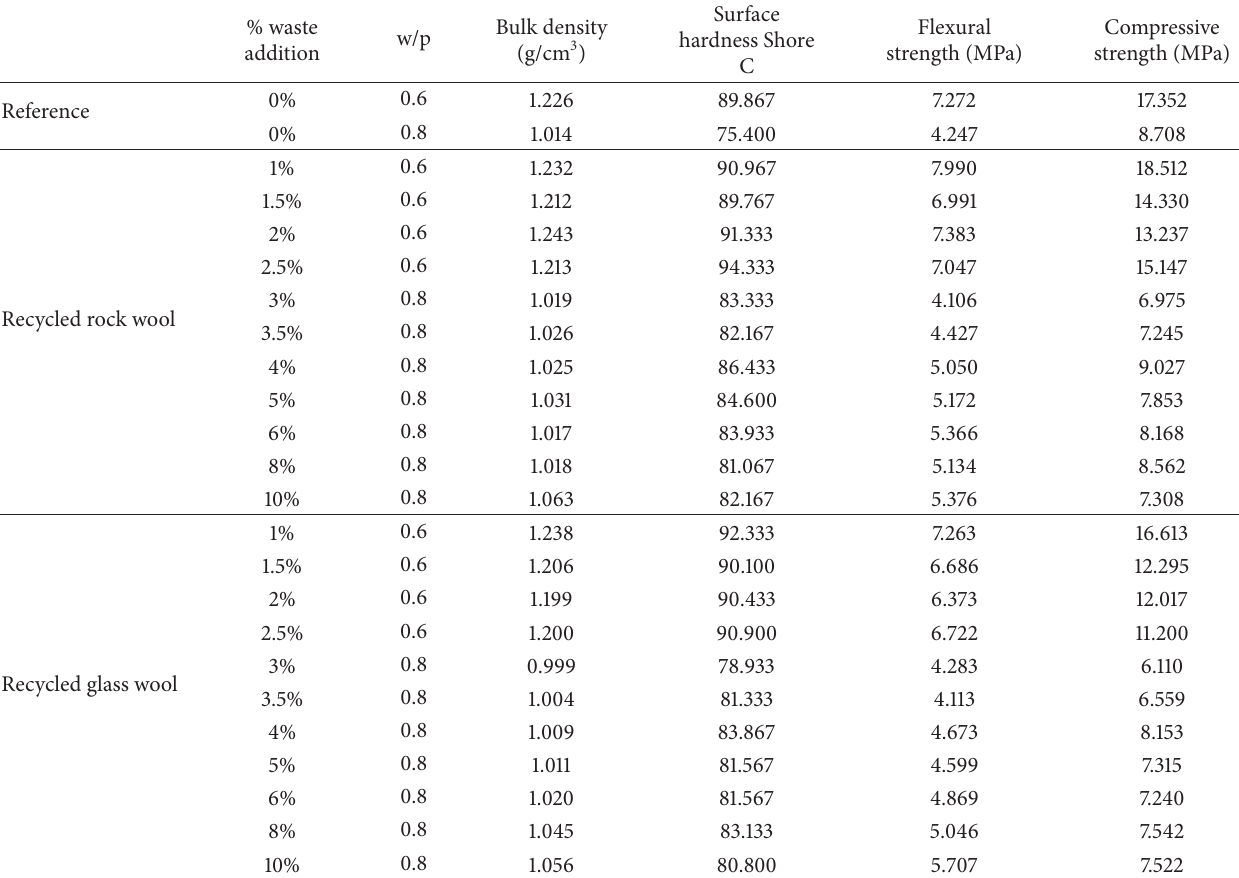
Table 6: Tests of average